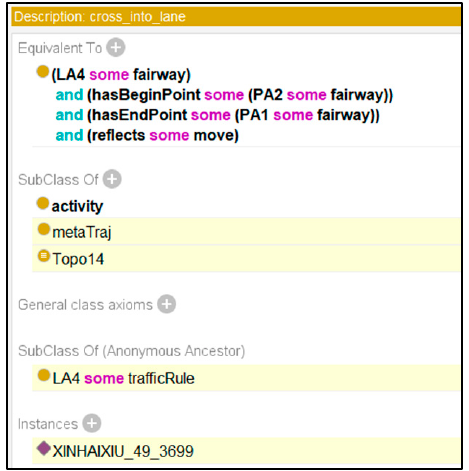
Figure 11. The reasoning results of activity behavior cross_into_lan e.